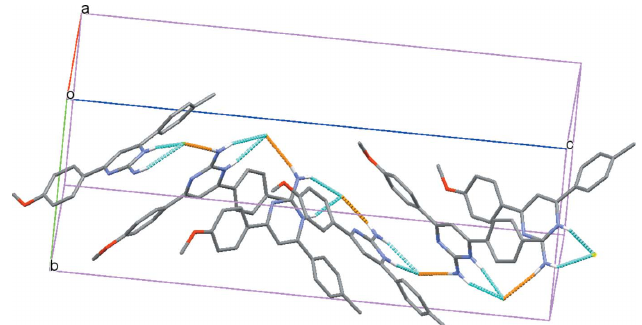
Figure 2 Part of the crystal structure with intermolecular hydrogen bonds are shown as red and blue dashed lines. For clarity, only those H atoms involved in hydrogen bonding are shown.